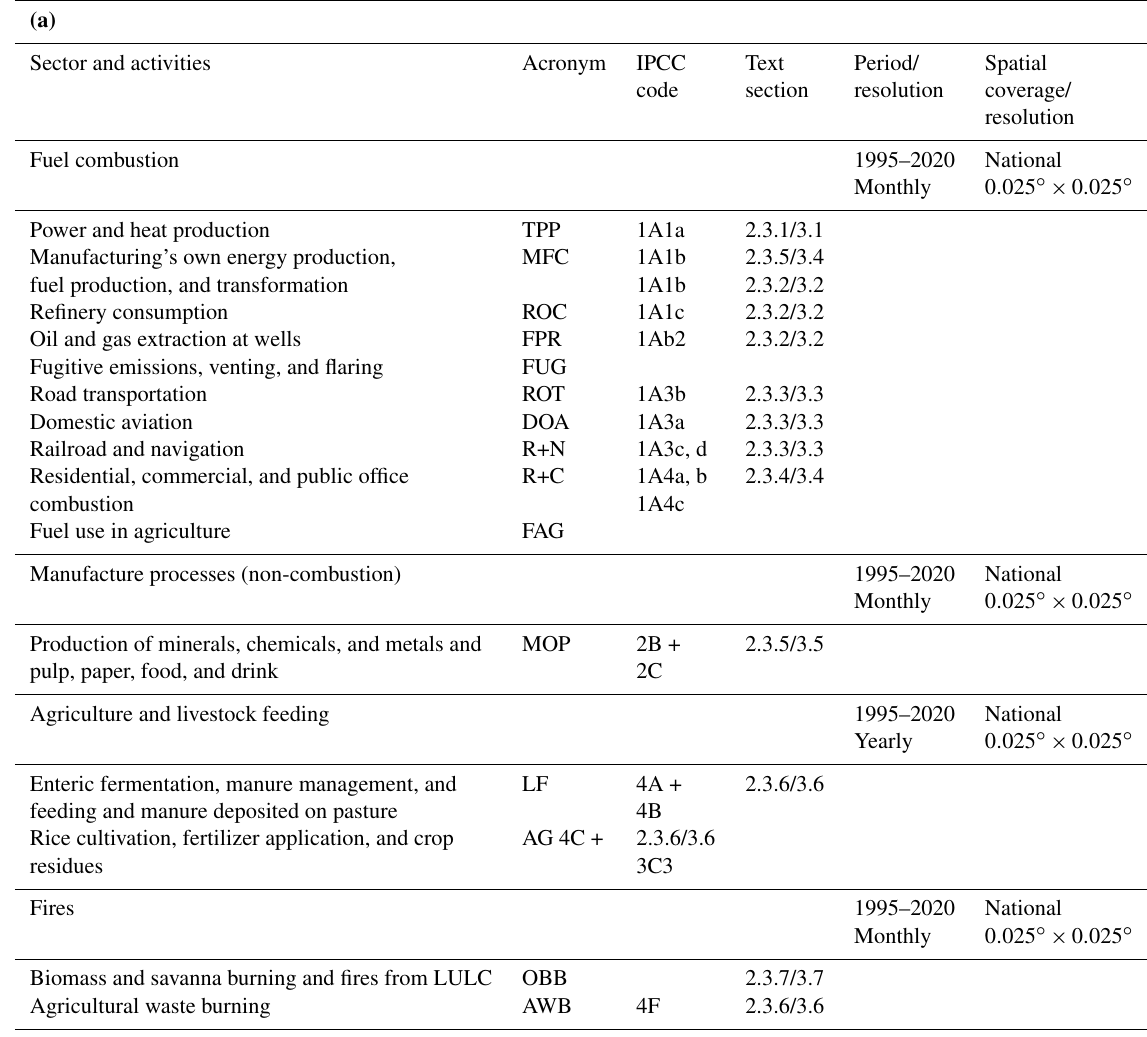
Table 1. (a) Sectors, activities, classification codes, and resolution considered in the GEAA-AEIv3.0M inventory. (b) Sectors, activities, and pollutants considered in the GEAA-AEIv3.0M